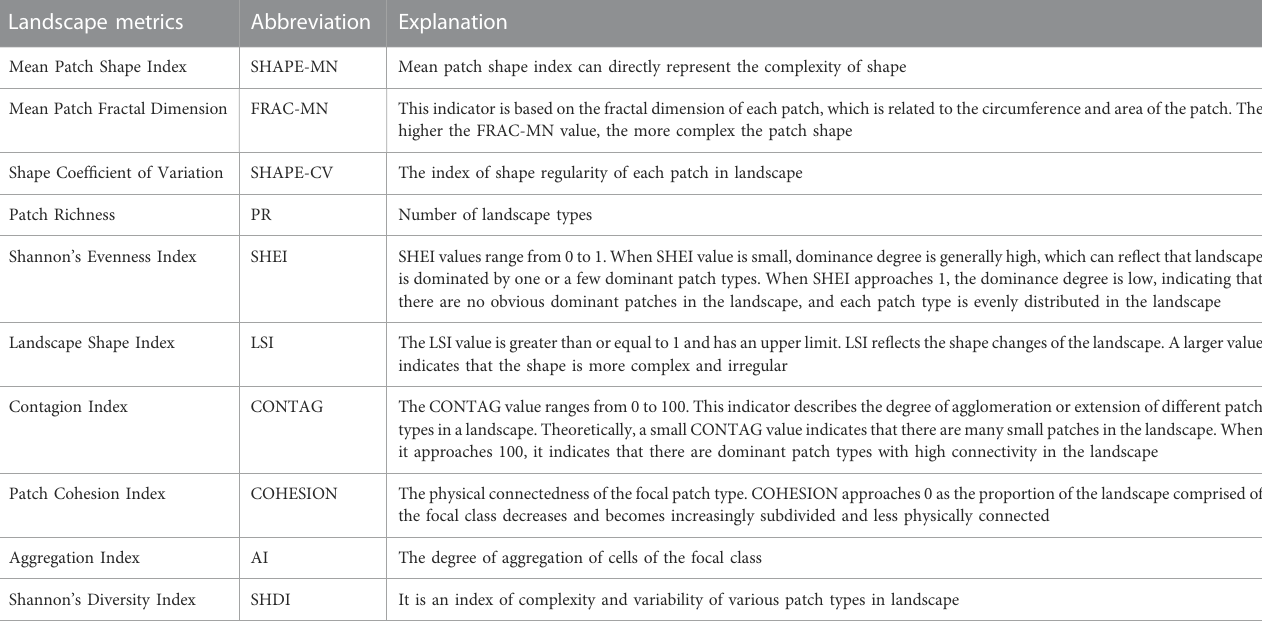
TABLE 2 Landscape metrics used in this